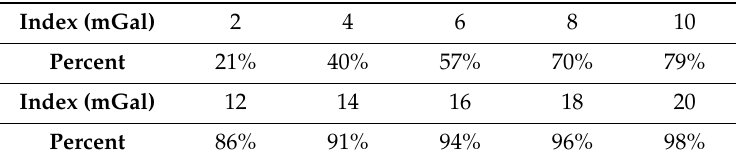
δ g derived from HY-2A ( a ) and the di ff erence ( b ) between δ g and those from EGM08. Figure 5. Figure 5. Table 3. Error magnitude